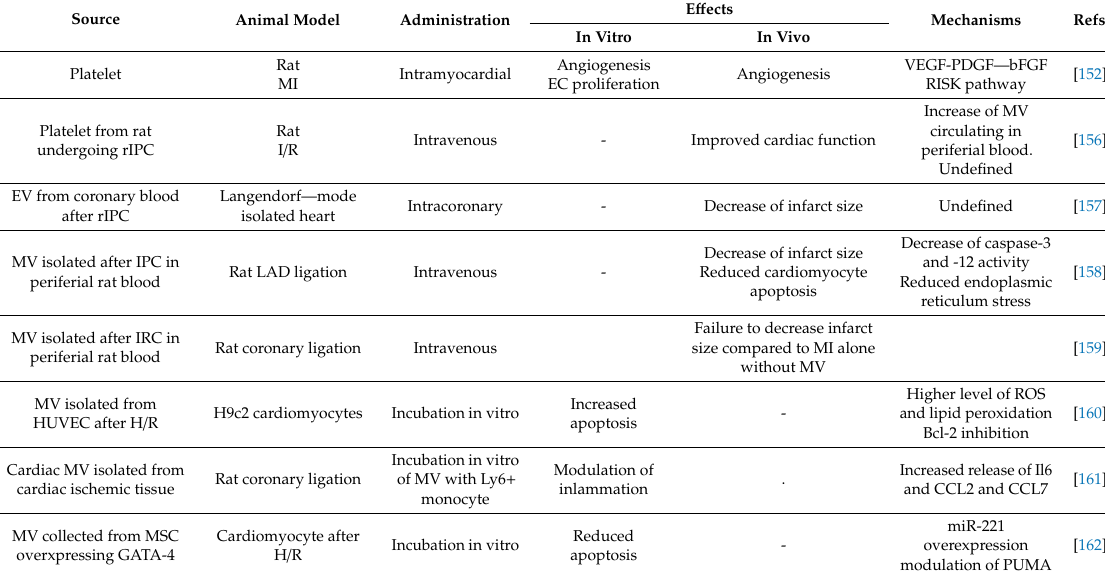
Table 2. MV role in ischemic